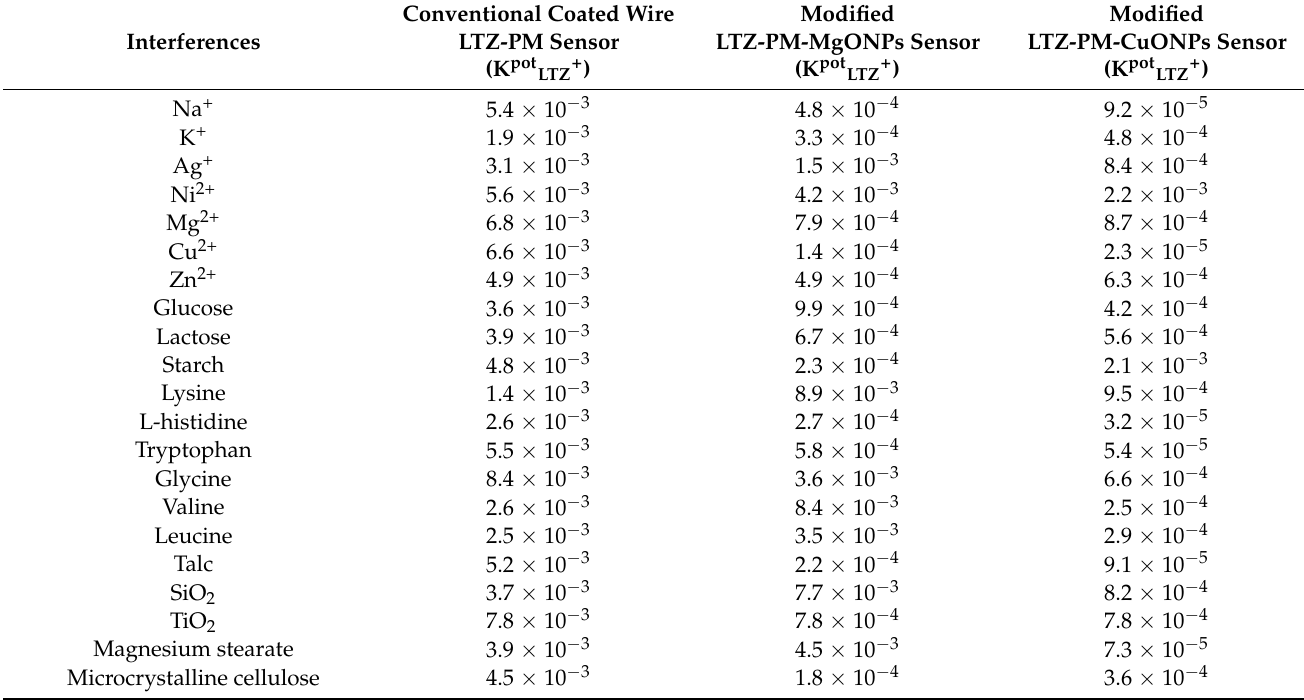
Table 2. Selectivity coefficient (K Pot LTZ+ ) of conventional coated wire LTZ-PM, modified LTZ-PM-MgONPs and